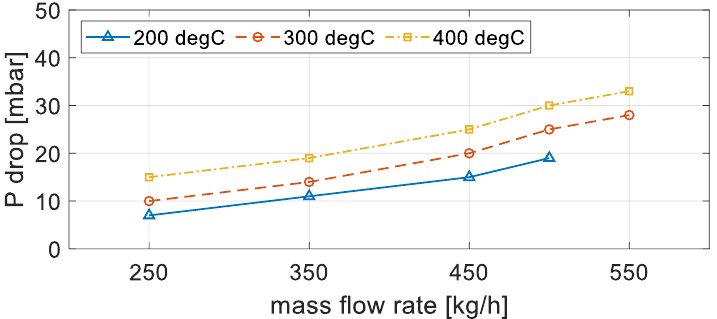
Figure 3. Differential pressure history at DPF with zero PM according to exhaust mass flow rate and exhaust temperature. Table 2. Differential pressure values at DPF with zero PM condition.